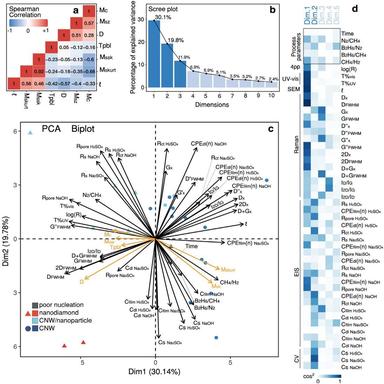
(a) Correlation between the SEM-derived parameters (b) Scree plot, (c) Principal Component analysis and (d) cos2 heatmap for the first five dimensions.